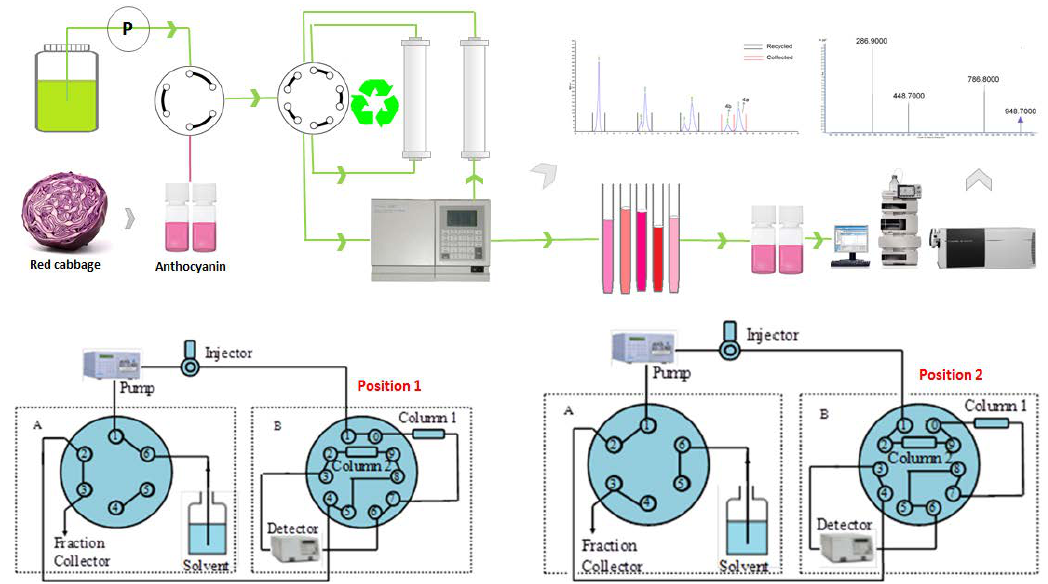
Figure 7. The schematic diagrams illustrating the extraction, separation, direct recycling, and alternate recycling systems.